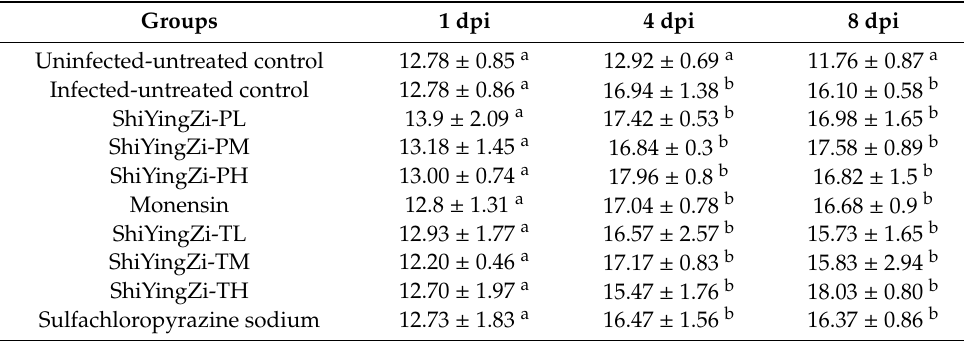
Table 8. The globulin content (g / L).